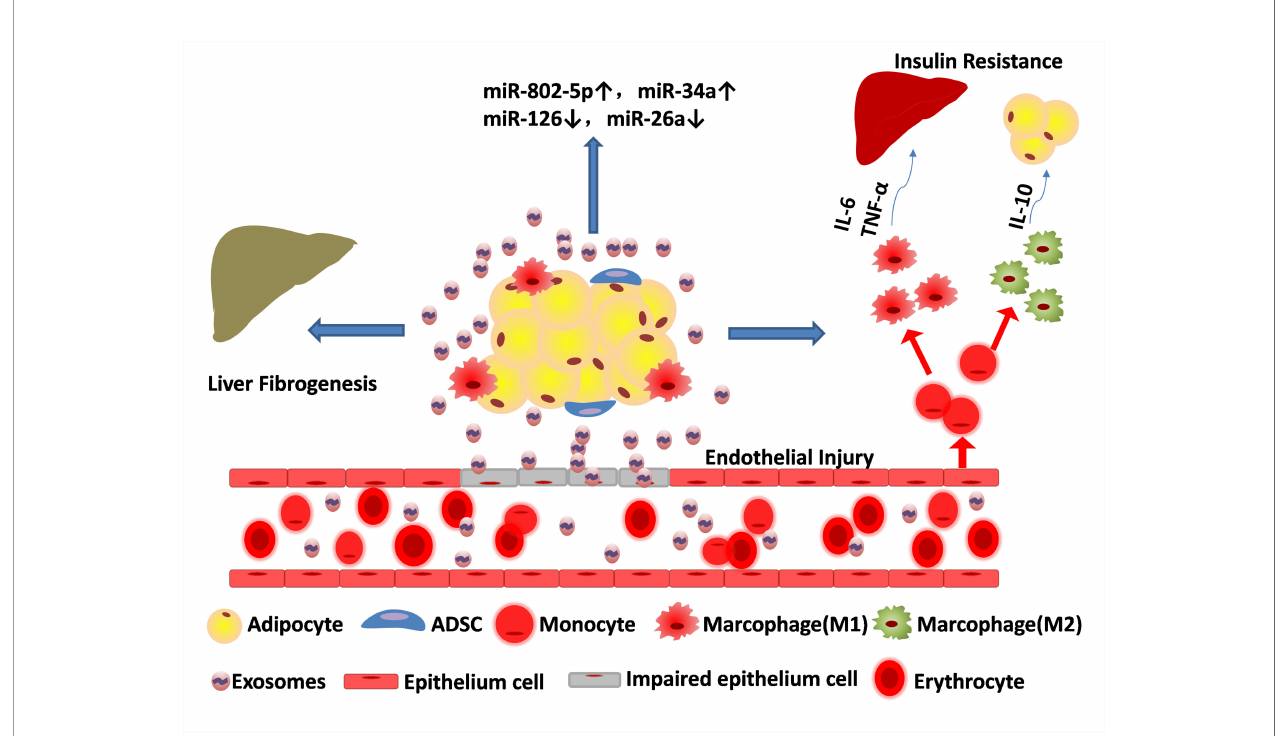
FIGURE 2 | Adipose tissue-derived exosomes result in metabolic disorders. Exosomes released from adipose tissue can destroy the epithelium cell, ruin the blood vessels, aggravate liver fi brogenesis and promote transformation of monocyte to both macrophage (M1 pro-in fl ammatory phenotype) and macrophage (M2 anti- in fl ammatory phenotype). Cytokines such as IL-6 and TNF- a released by M1 can affect systemic metabolism and exacerbate insulin resistance, while IL-10 released by M2 can alleviate adipose in fl ammation. The content of miRNAs in adipose tissue-derived exosomes are partially upregulated (e.g. miR-802-5p, miR-34a) and some are down regulated (miR-126,